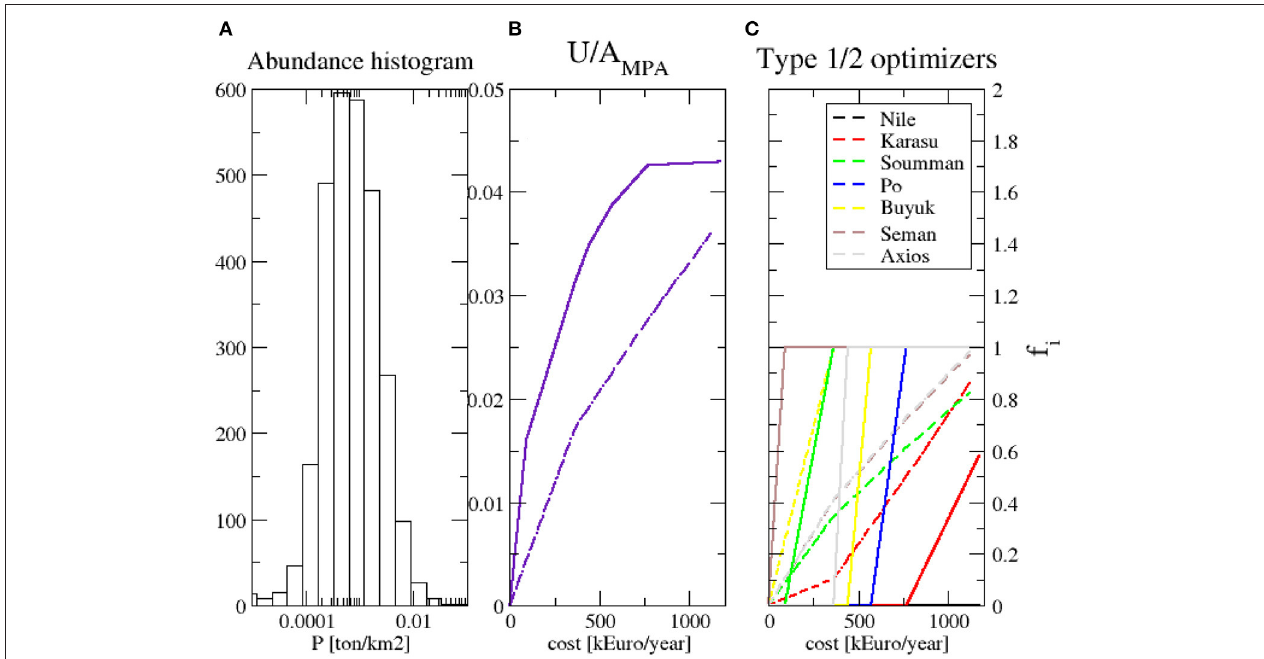
FIGURE 10 | (A) Histogram of average Mediterranean macro plastic density on assessment grid within Natura 2000 MPAs in Figure 5 . (B) MPA integrated benefit of cleanup per area U / A MPA as function of cost for fixed-objective (type 1, dashed line) or best-value-per-cost (type 2, full line). End point on dashed curve correspond to at least 10% local pollution reduction at all feasible points on assessment grid. For the plot we applied P † = < P > MPA so BAU reference scenario ( f = 0) corresponds to U / A MPA = 0 and full cleanup ( P ( x ) = 0) of all sources (also beyond 6 river in Table 1 corresponds to U / A MPA = 1 (C) Cost-minimizing solution f for different river sources in Table 1 corresponding to B ) for type 1 optimization (dashed curves) and type 2 optimization (full